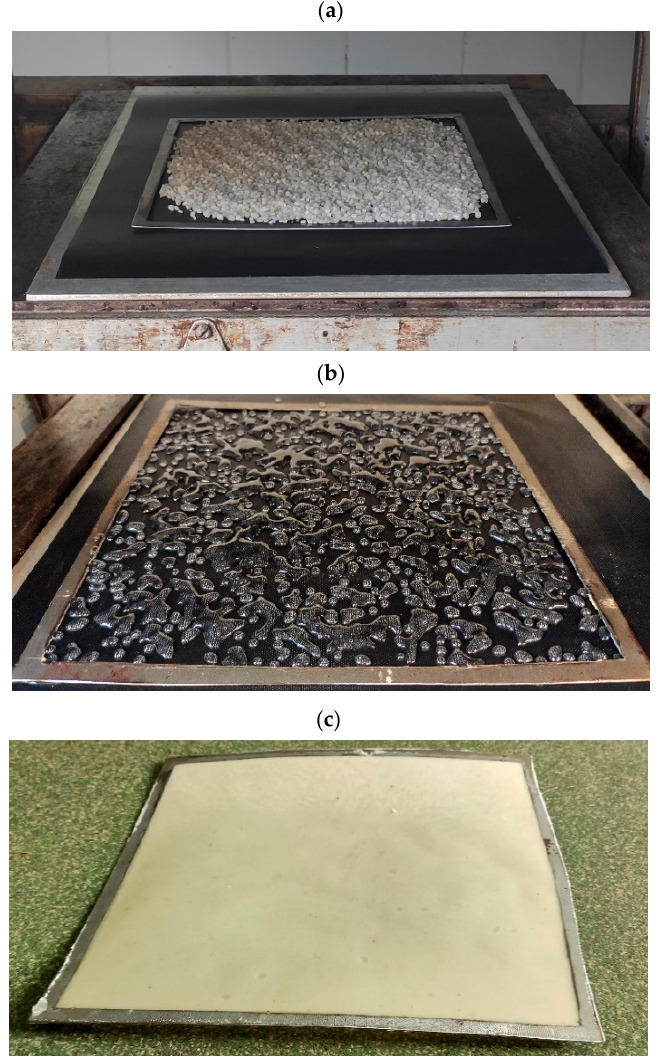
Figure 1. ( a ) Overheating phase of the granules of biopolymers and biopolymer blends; ( b ) molten pellets (PLA in this case); ( c ) adhesive biopolymer layer.